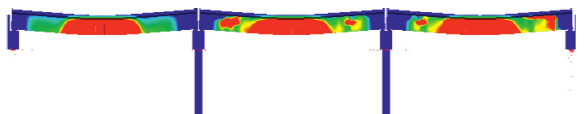
Figure 28: Principal normal strain at the end of the analysis, model “A3-S-C.”